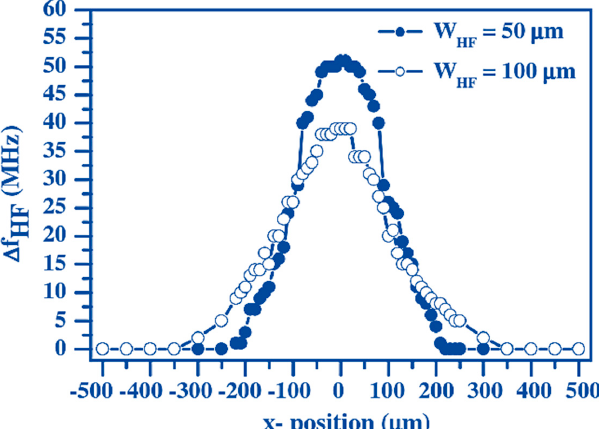
Figure 11. 1D scans ( x -direction) above a stainless steel plate with a 200- µ m-wide notch measured using the 50- and 100- µ m-wide high-frequency stub filters for a probe-to-metal distance d = 50 µ m. Variations of the high-frequency stub frequency ( ∆ f HF ) as a function of the x position; x = 0 corresponds to the middle of the notch (from [29]; copyright © 2008; redesigned with permission).